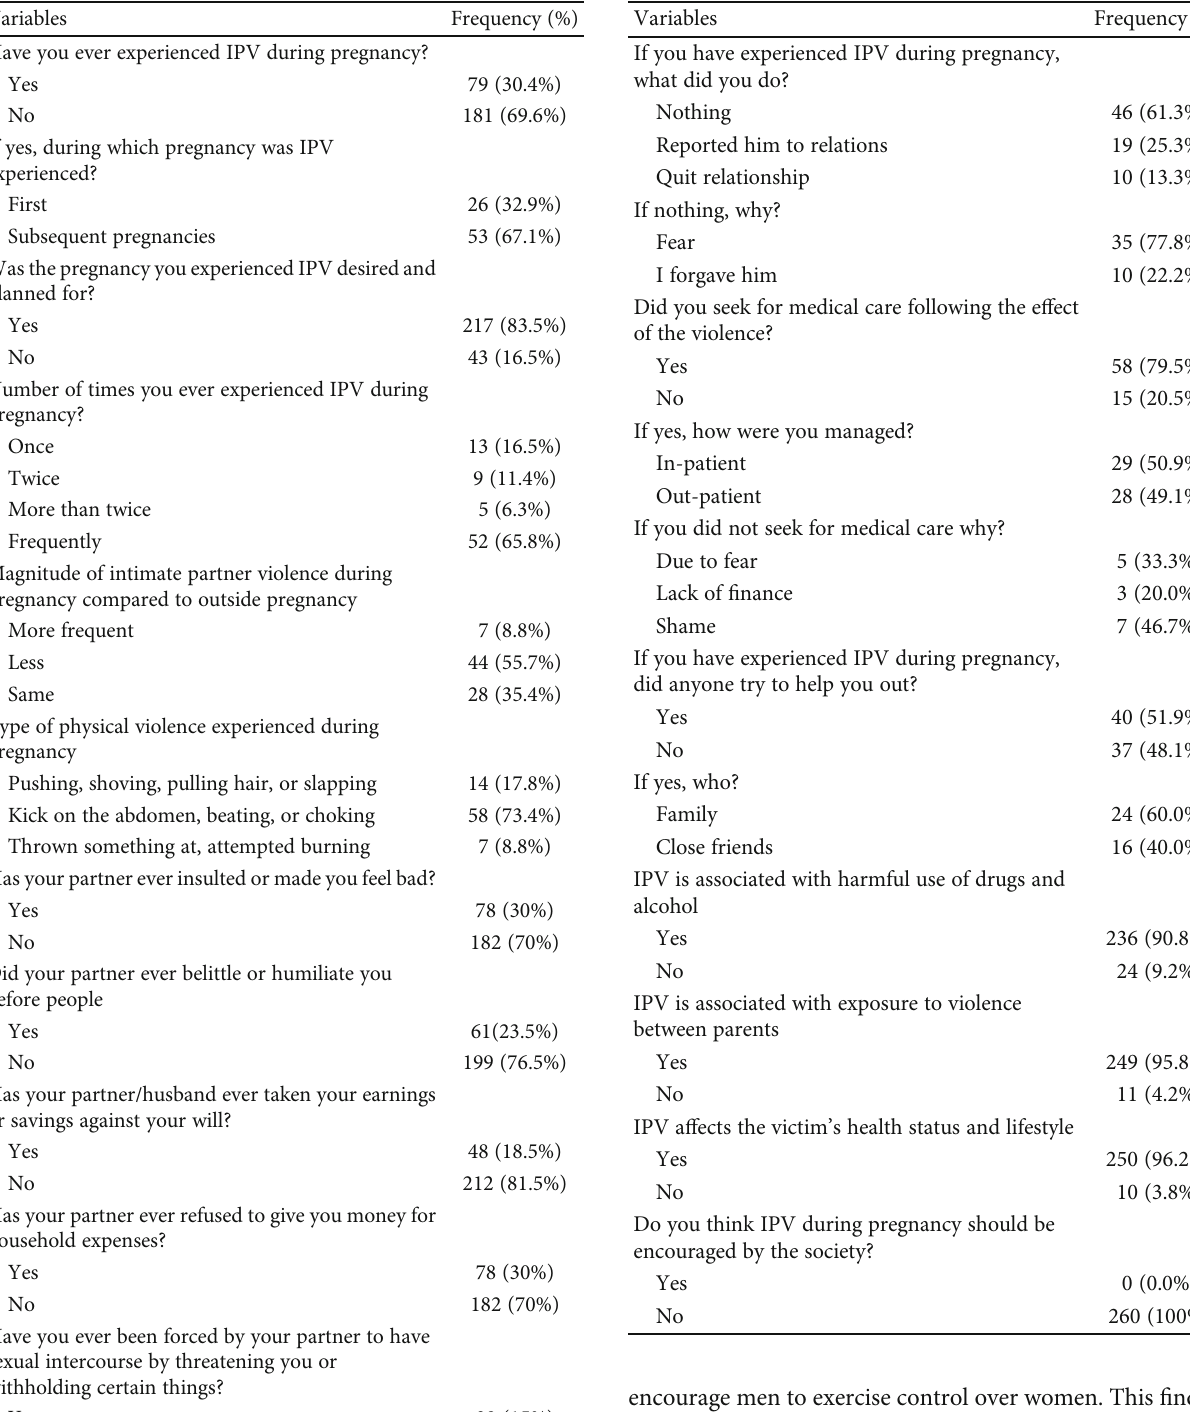
Table 3: Experience of women on various forms of IPV during pregnancy.